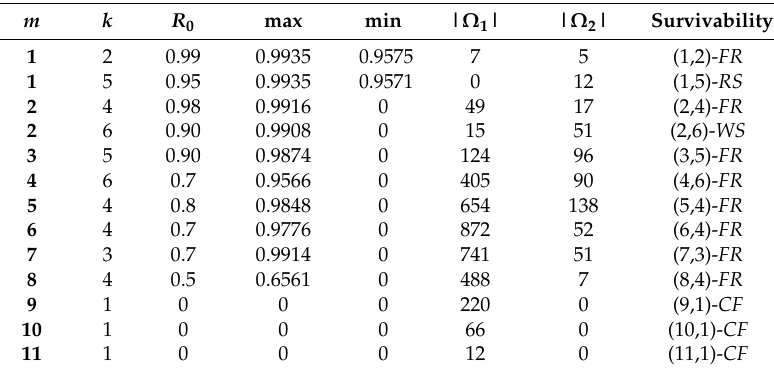
Table 2. Cascading failure evaluation for Figure 3.